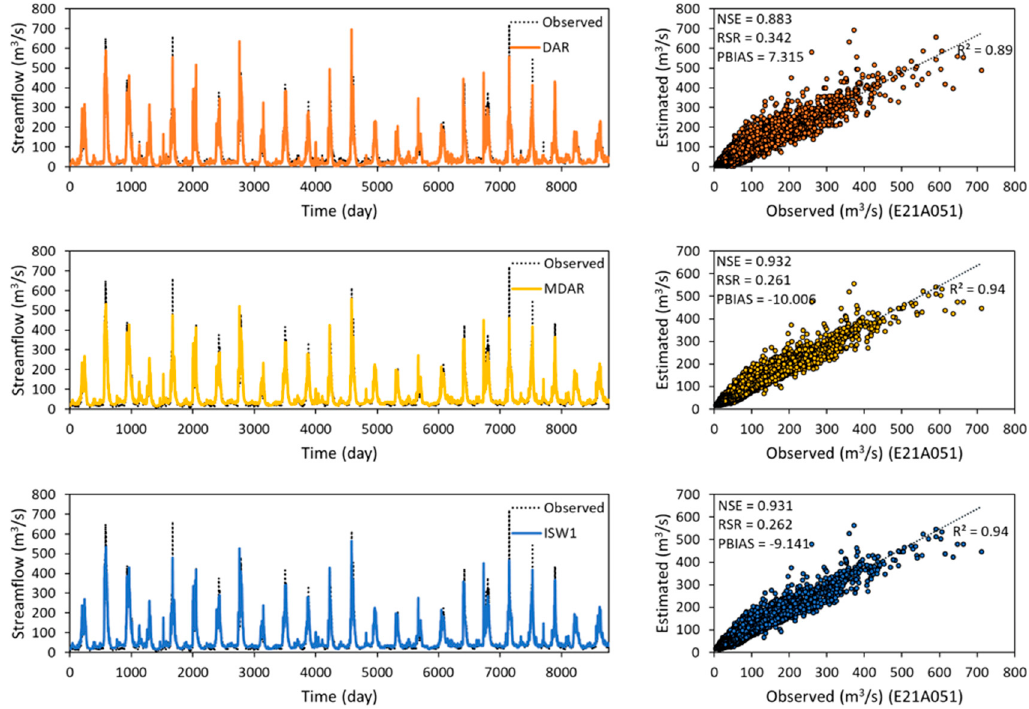
Figure 8. Comparison of daily streamflow estimated using DAR (top row), MDAR (mid row), and ISW1 (bottom row) with observed (original) daily streamflow at station E21A051 in the Upper Euphrates Basin.